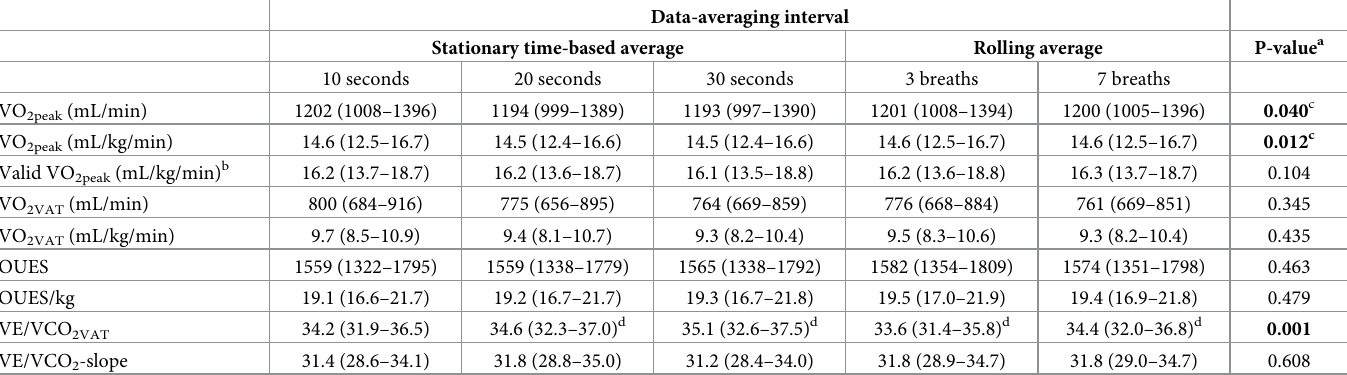
Table 2. Numerical values of CPET variables using different data-averaging